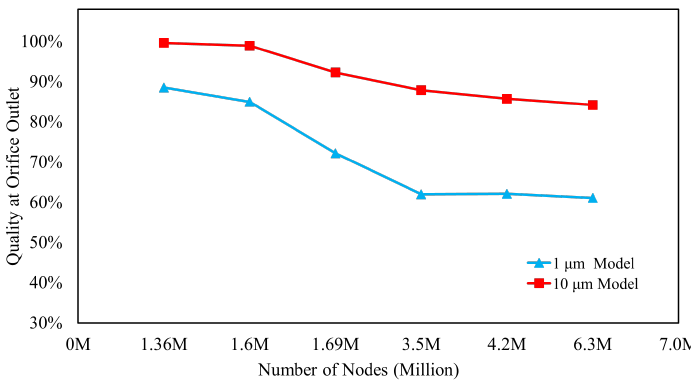
Figure 3. Results of mesh